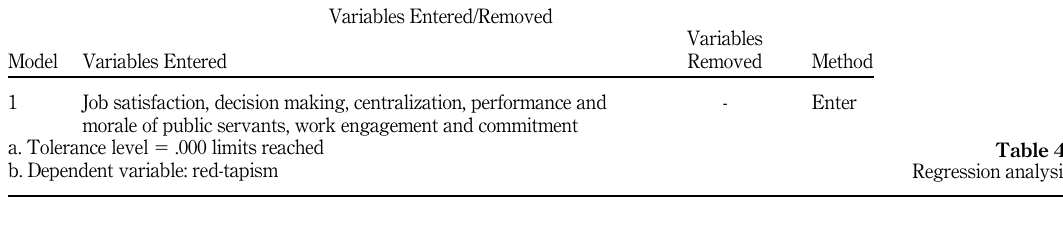
Table 4. Regression analysis